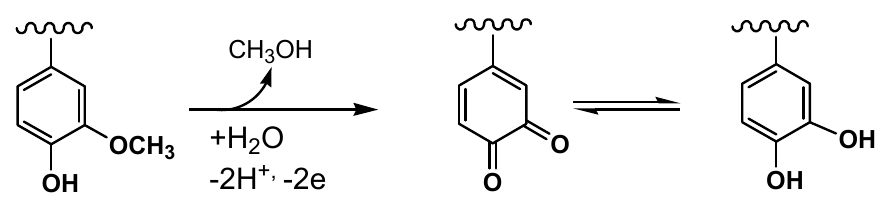
Scheme 1. Electrochemical transformation of methoxyphenol moieties contained in lignins into quinone/hydroquinone redox couples [4].